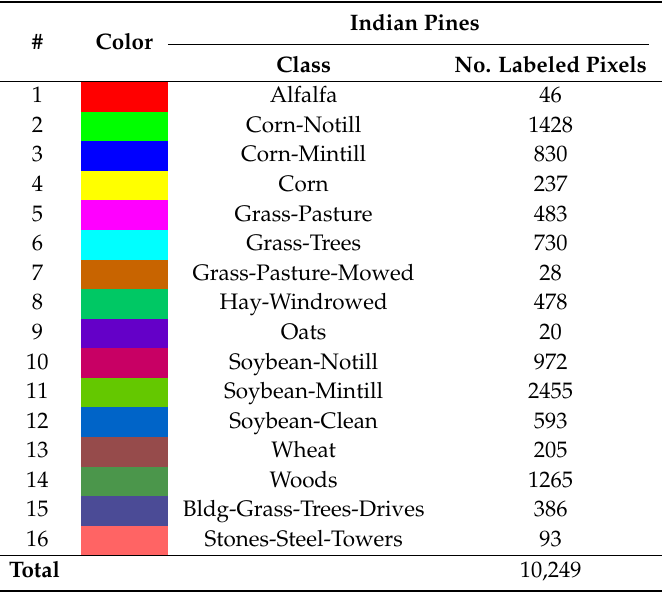
Table 2. Class information and labeled spectrum numbers of Indian Pines.